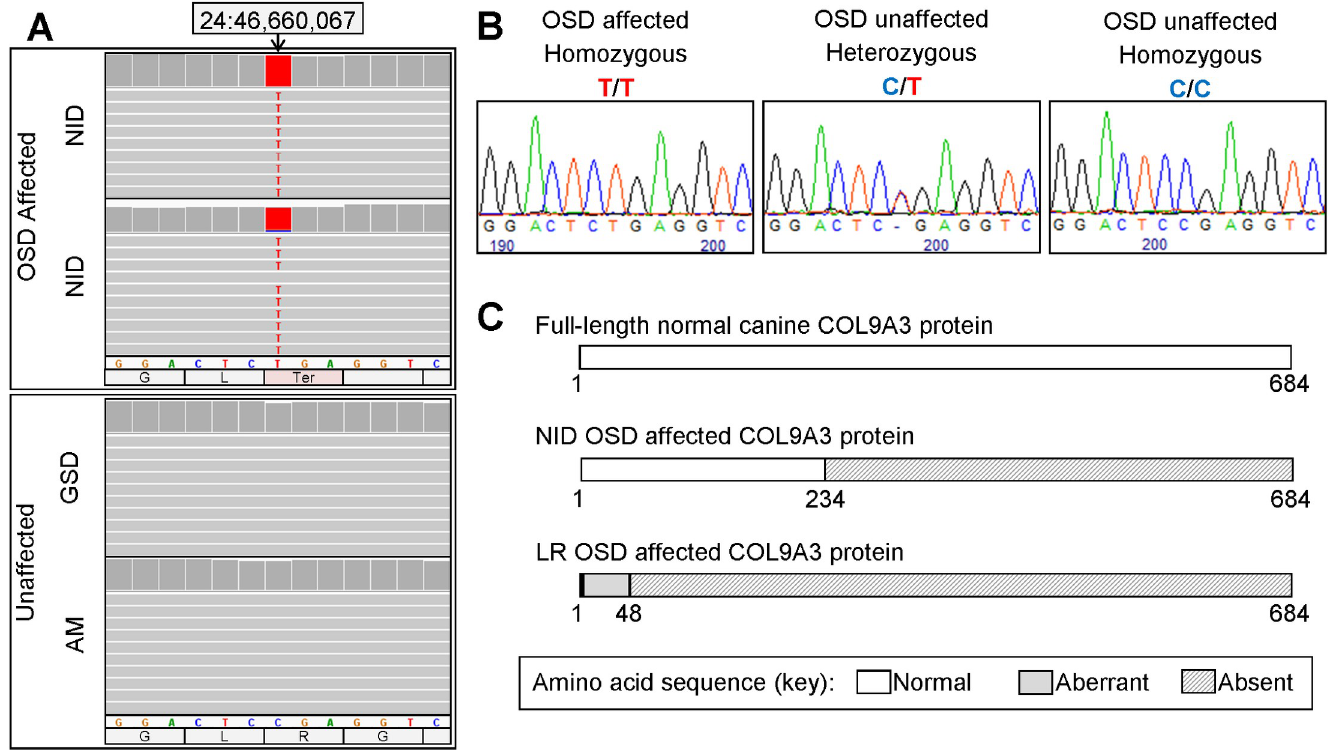
Fig 6. Nonsense SNP identified in COL9A3 . COL9A3 c.700C > T (at chr24:46,660,067 in CanFam3.1) was identified by interrogation of WGS using IGV (A) and confirmed by Sanger sequencing (B). Oculoskeletal dysplasia (OSD)-affected NID were homozygous for the variant (T/T); obligate carrier Northern Inuit Dogs (NID) were heterozygous (C/T); OSD-unaffected NID were either heterozygous or homozygous for the wildtype allele (C/C); and all non-NID breeds were homozygous for the wildtype allele (C/C). The variant is expected to change codon 234 from CGA (encoding Arginine) to TGA (a termination codon), resulting in a protein that is significantly truncated (C). The COL9A3 frameshift variant reportedly associated with OSD in Labrador Retriever is predicted to disrupt the entire protein, resulting in 48 aberrant amino acids before a premature termination codon.